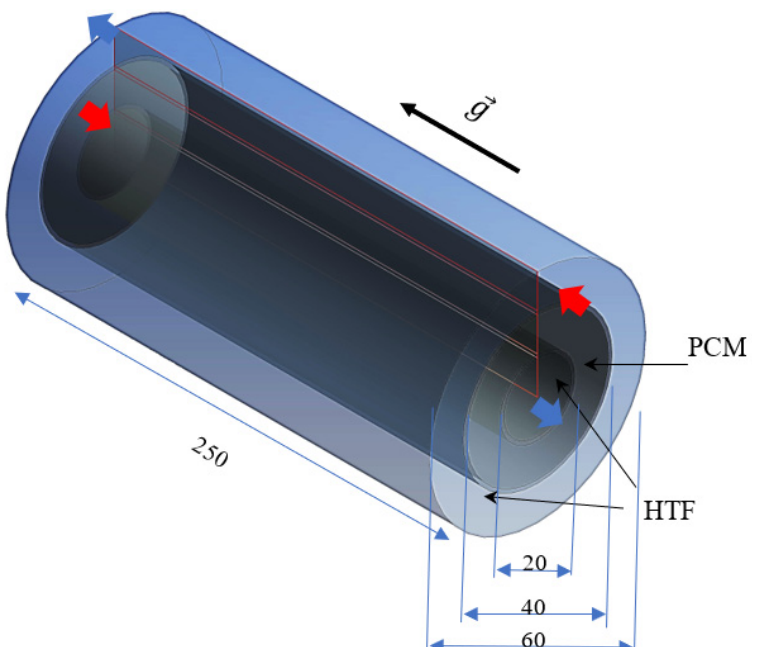
Figure 2. The schematic of the studied vertical triple-tube heat exchanger (all the dimensions are in mm).